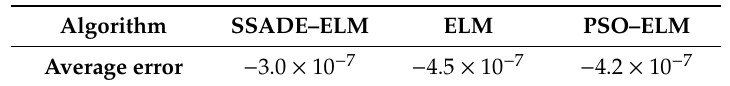
Swarm Strategy Self-Adaptation Differential Evolution–Extreme Learning Machine, PSO–ELM = Particle